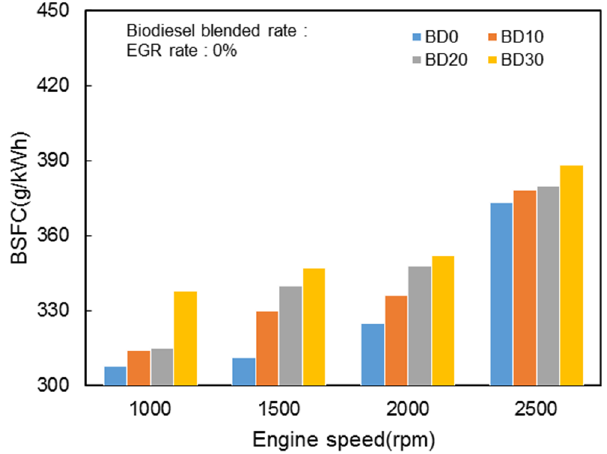
Figure 4. Effects of the biodiesel blend ratio and engine speed on the brake specific fuel consumption (BSFC).